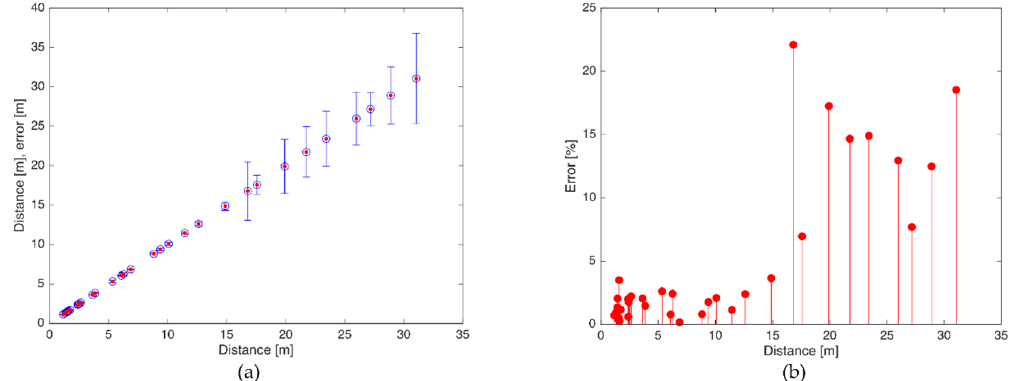
Figure 17. 3D scanner precision: ( a ) Error graph; ( b ) Error in percent.